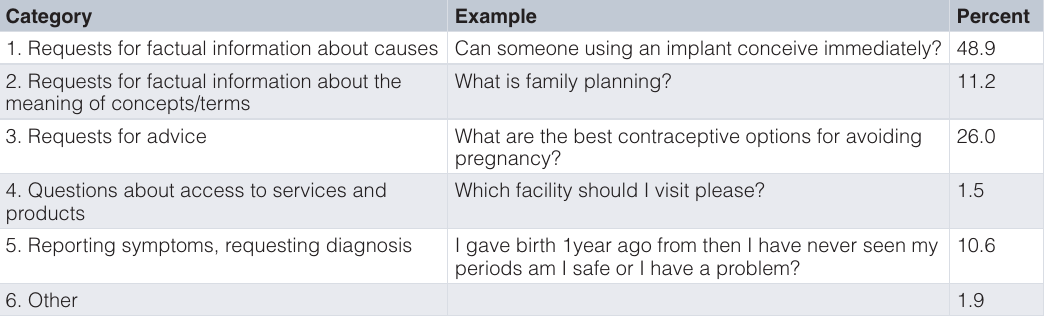
Table 3. Distribution of user